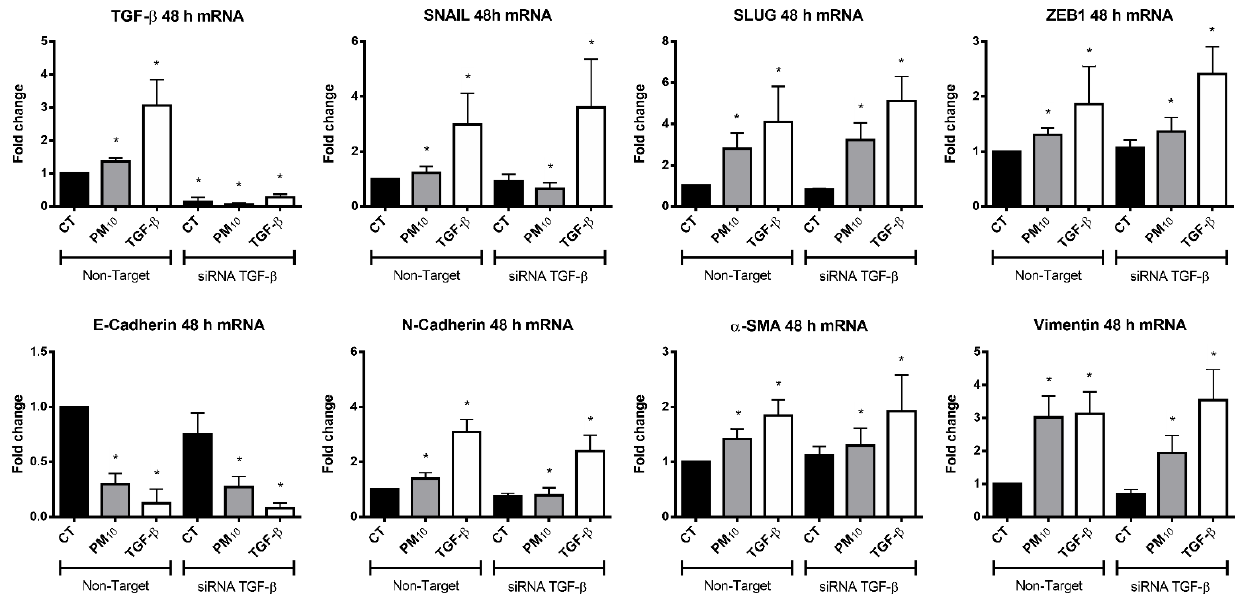
Figure 2. Particulate matter PM 10 induces the expression of TGFB1 and EMT components in A549 cells after 48 h of treatment. Particulate matter exposure increases the expression levels of TGFB1, SNAI1 (Snail), SNAI2 (Slug), ZEB1 (ZEB1), CDH2 (N-cadherin) ACTA2 ( α -SMA), and VIM (vimentin), and decreases the expression levels of CDH1 (E-cadherin), while TGF- β treatment increases the expression levels of TGFB1 , SNAI1 (Snail), SNAI2 (Slug), ZEB1 (ZEB1), CDH2 (N-cadherin), ACTA2 (α-SMA), and VIM (vimentin), and decreases the expression levels of CDH1 (E-cadherin) in cultures of A549 cells transfected with non-targeting siRNA. These effects are prevented by TGFB1 siRNAs only in TGFB1 , SNAI1 (Snail), CDH2 (N-cadherin), and VIM (vimentin). Cells were exposed to PM 10 (10 µg/cm 2 ) and TGF-β (5 ng/mL) for 48 h. The quantitative results were expressed after normalization using GAPDH as a control. Data are reported as the means ± SD of three independent experiments. The images are representative of the data obtained. (*) indicates statistically differences between treatments. Relative quantification or fold change (FC) was performed using the 2 −ΔΔCt ; p < 0.05.